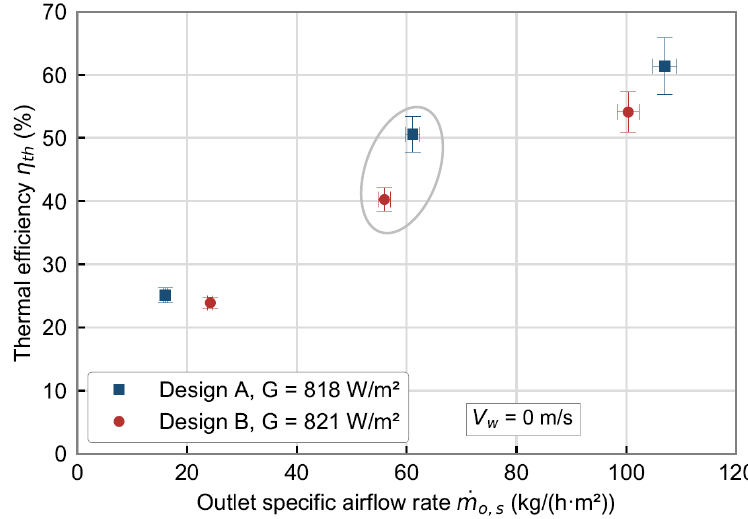
Figure 19. Thermal efficiency comparison as a function of the outlet specific airflow rate.